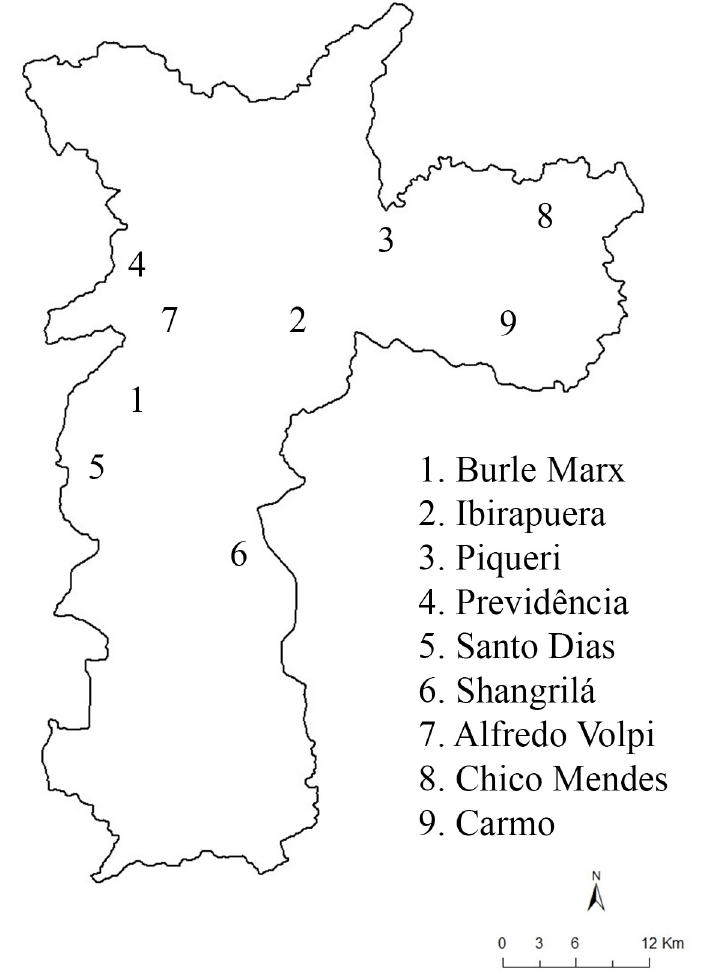
Fig 1. Aedes fluviatilis sampling locations in the city of S ã o Paulo.